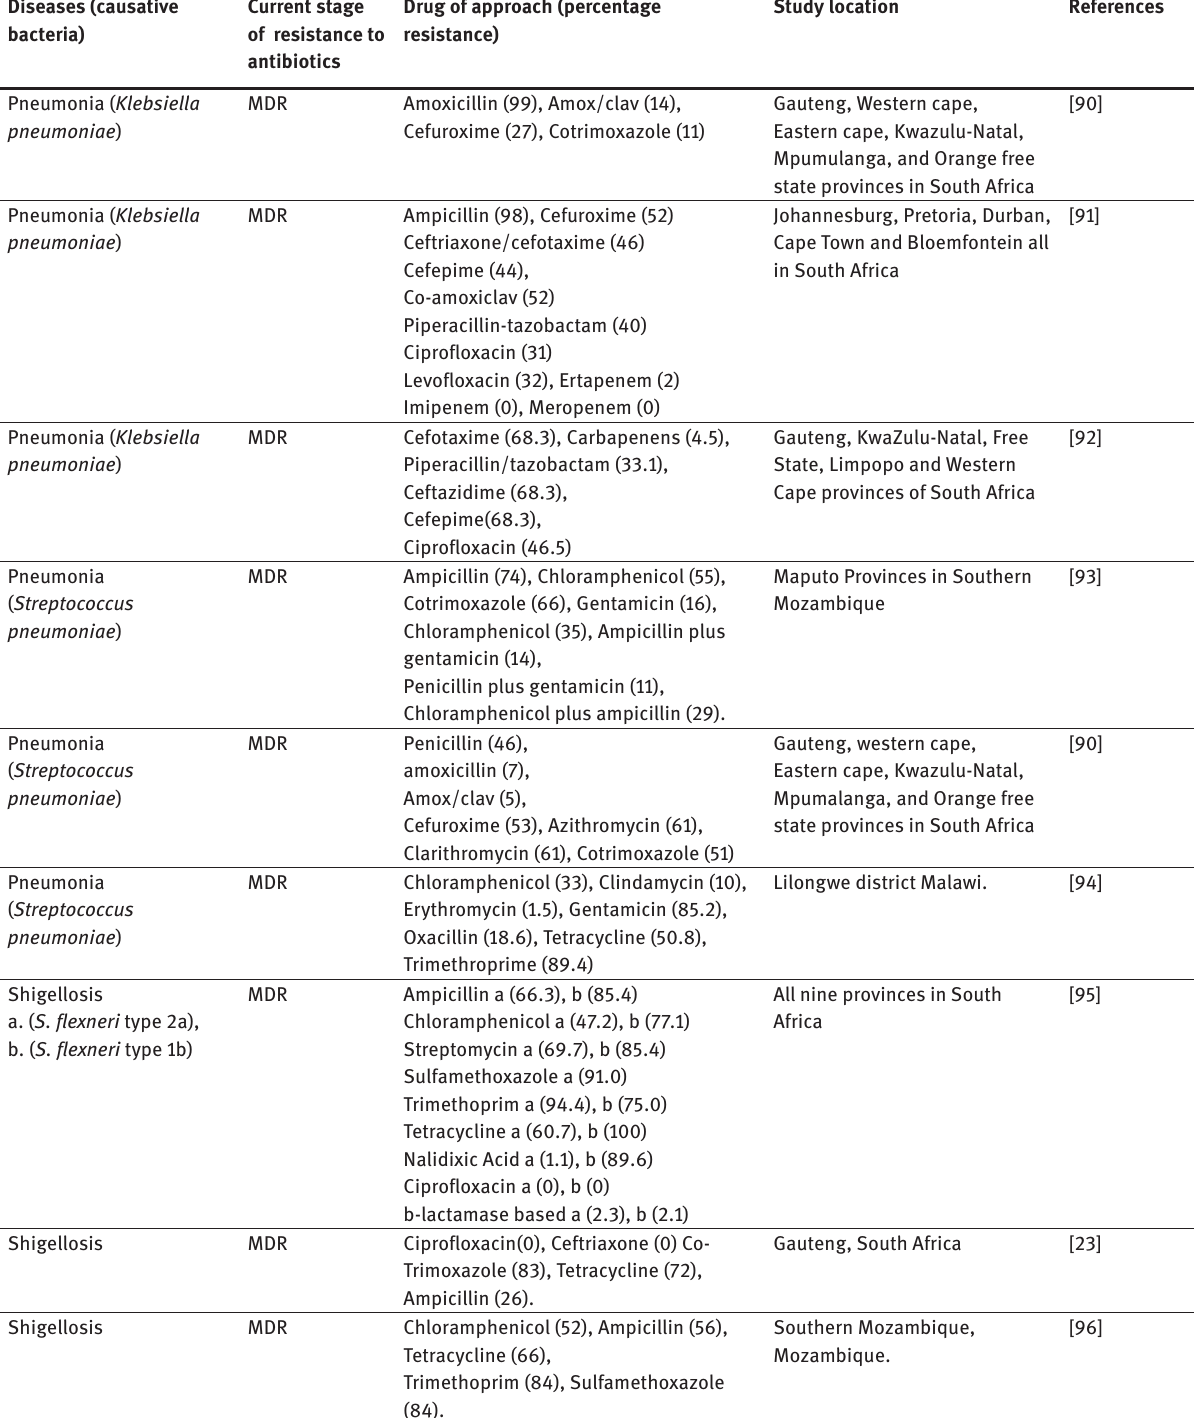
Table 1: Some bacterial diseases and reported antibiotic resistant statues. Diseases